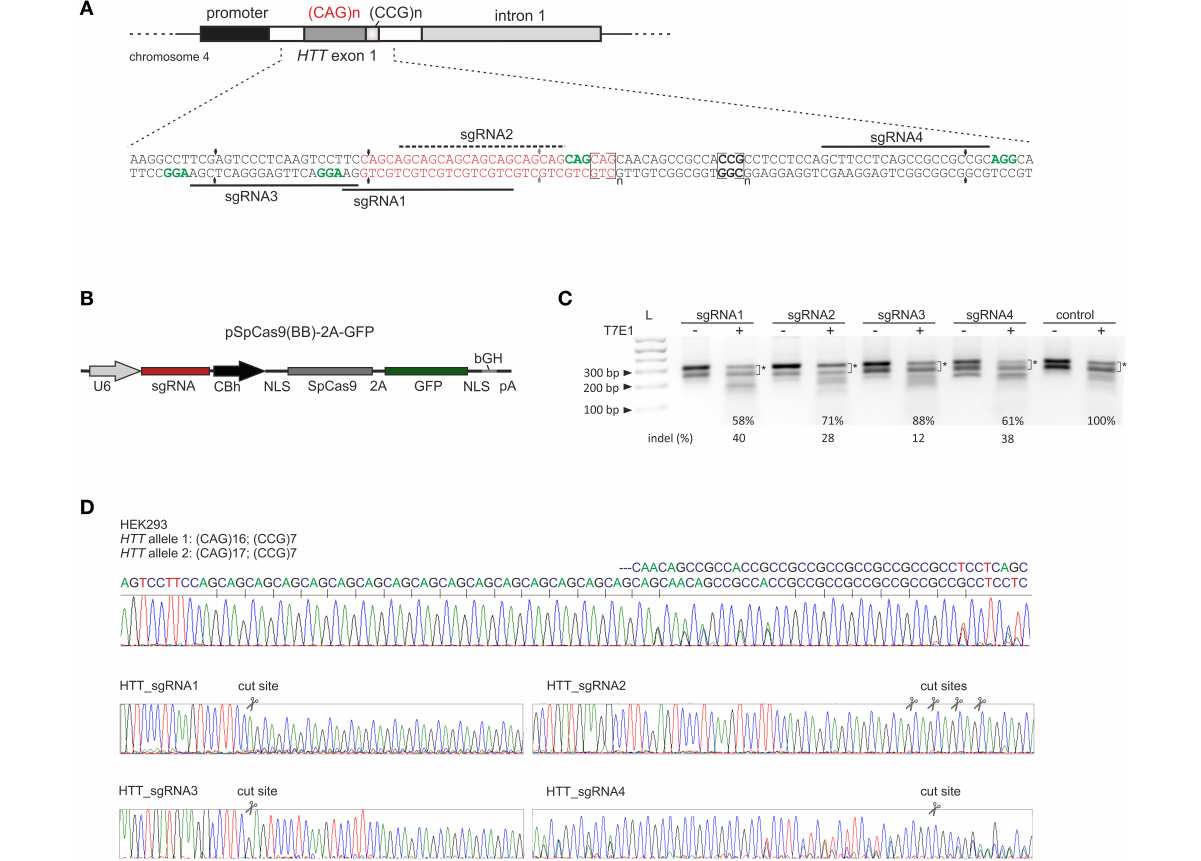
DNA was isolated 48 h post-transfection from unsorted